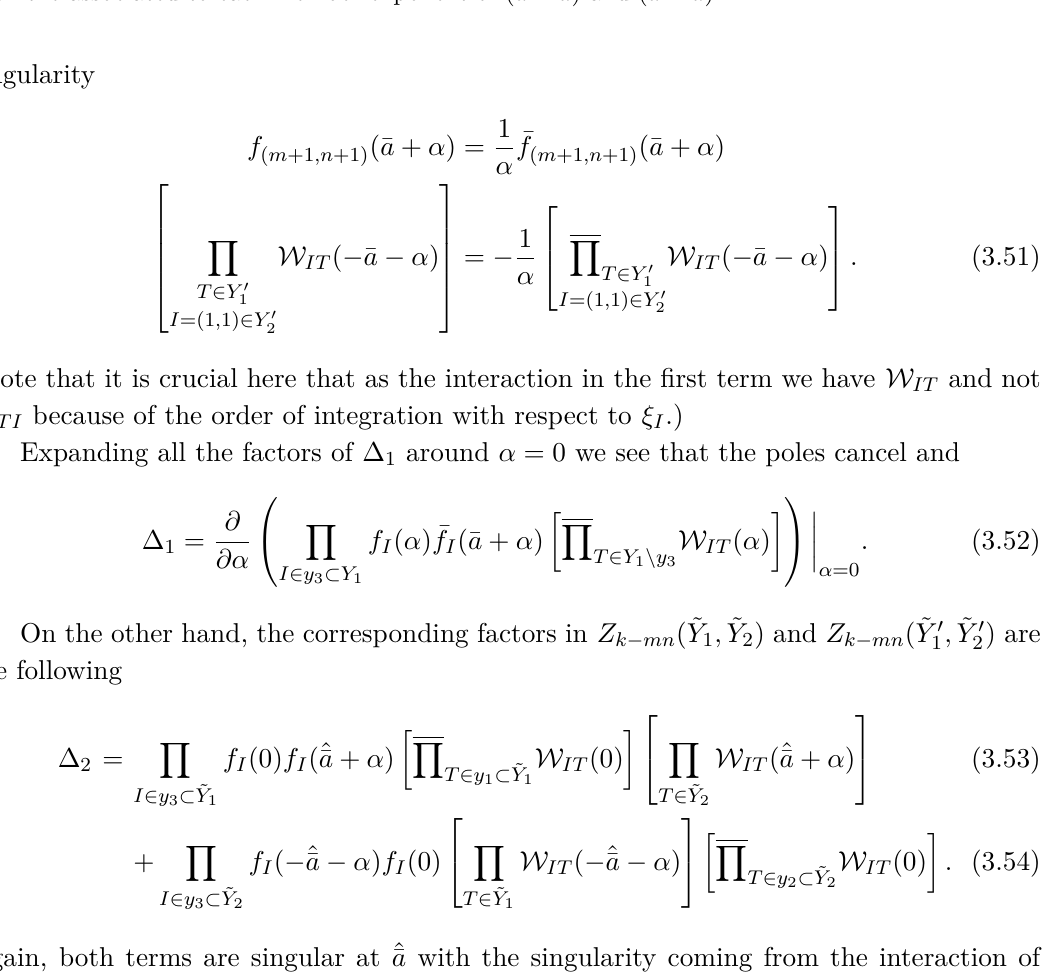
Figure 11 . Example of a family with a blinking group, but with no overlap, and its dual family with the associated to each member exponent of ( a − ¯ a ) and ( a − ˆ¯ a )